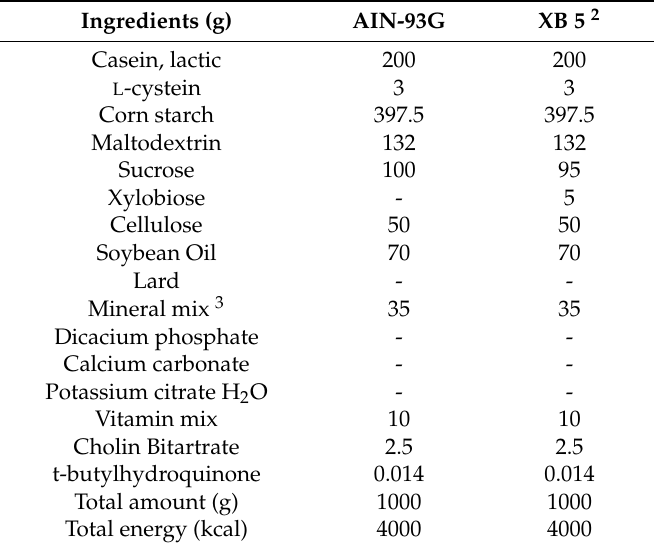
Table 1. Dietary composition for the experiment 1